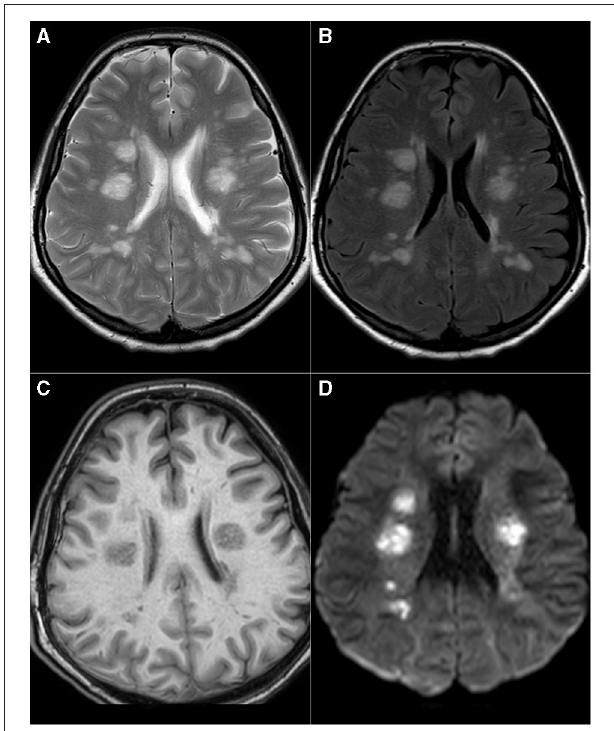
FIGURE 4 | Acute disseminated encephalomyelitis (ADEM). Multiple, bilateral T2 (A) and FLAIR (B) hyperintense foci present in periventricular areas of white matter, hypointense, or invisible on T1-weighted images (C) . These lesions show pronounced diffusion restriction seen as high-signal intensity on DWI images (D)